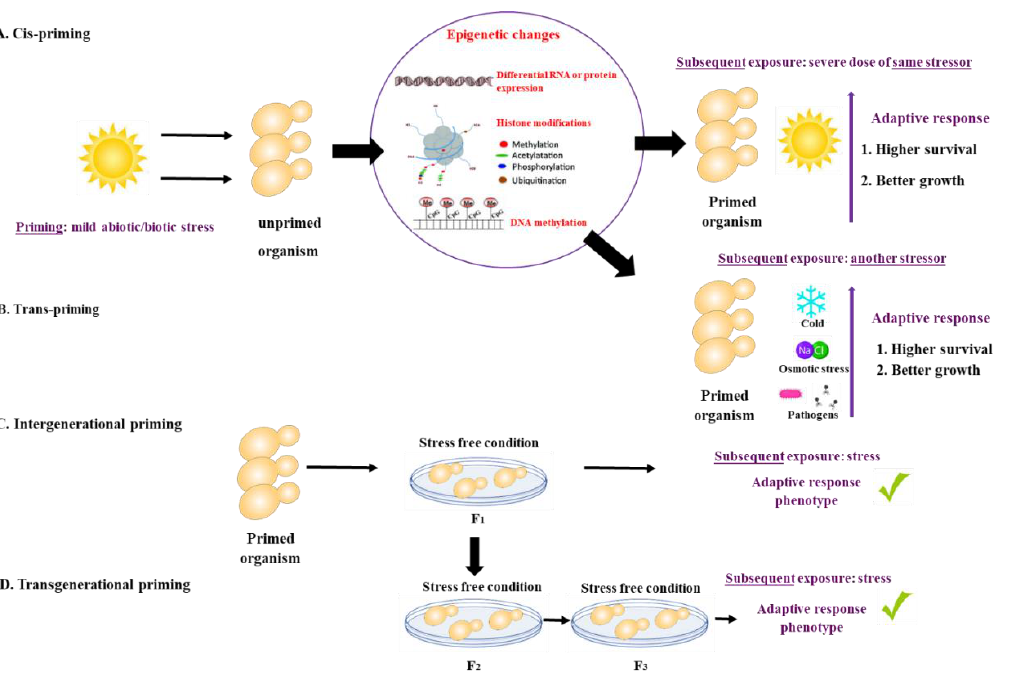
Figure 1. Priming is defined as a time-limited pre-exposure of an organism to a mild stress that leads to an increased adaptive response to subsequent exposures. ( A ) If the initial priming stress and the subsequent exposure are of the same nature, they are referred to as cis -priming. ( B ) If priming and exposure differ, they are termed trans -priming. Mechanisms of priming include differential RNA or protein expression and storage, histone modifications and DNA methylation. ( C ) Intergenerational priming occurs when the stress memory is observed in the first, stress-free offspring generation, while ( D ) trans-generational priming is observed after more than two stress-free offspring generations.